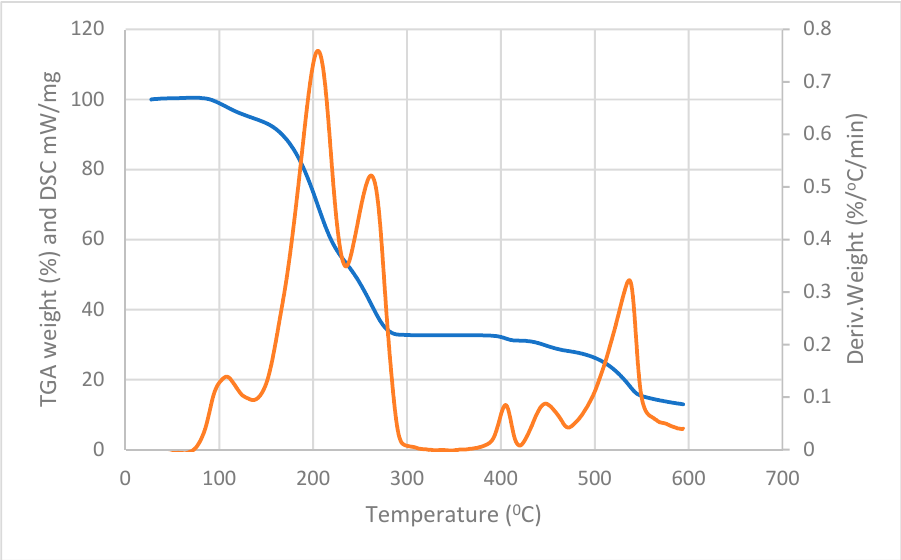
Figure 6. TGA and DSC plot of antimony(III) N -methyl- N -phenyl dithiocarbamate complex. The blue color is the TGA plot while the orange color is the DSC plot.